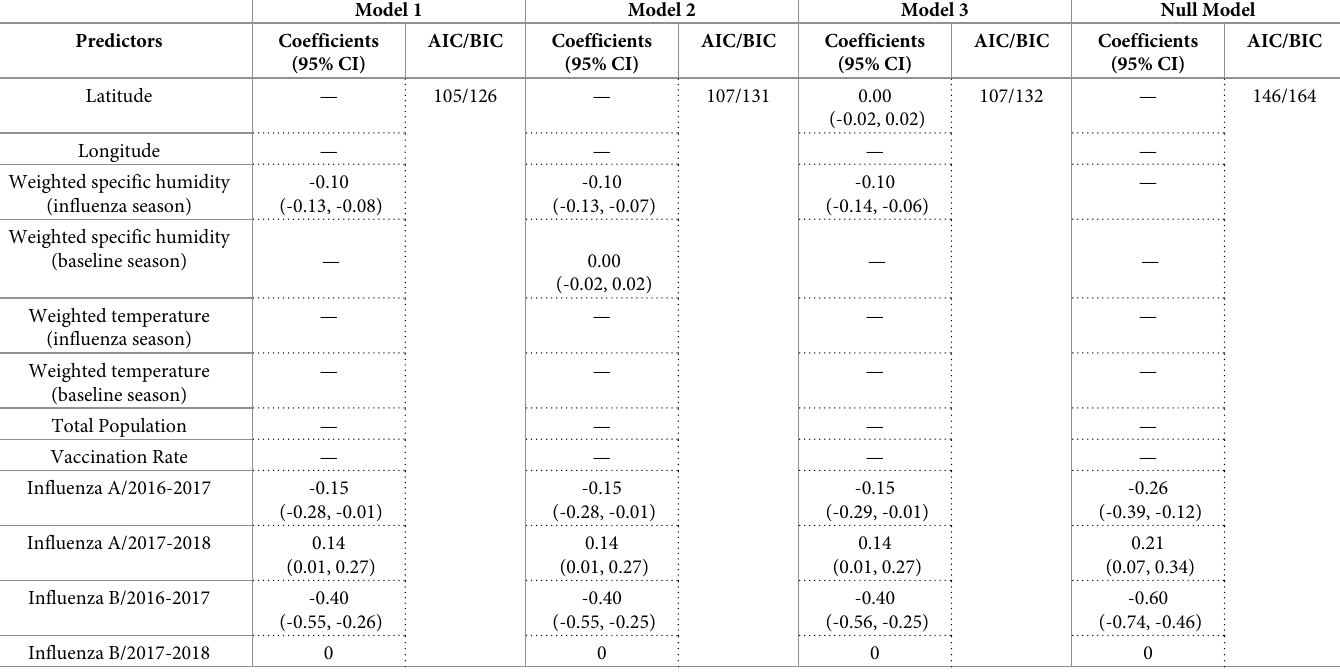
Table 4. Results of select multivariate mixed-effects regression models where the log cross-seasonal ratio was the dependent variable. The models were sorted in ascending order by AIC. A null model that only includes the dummy variables was included for